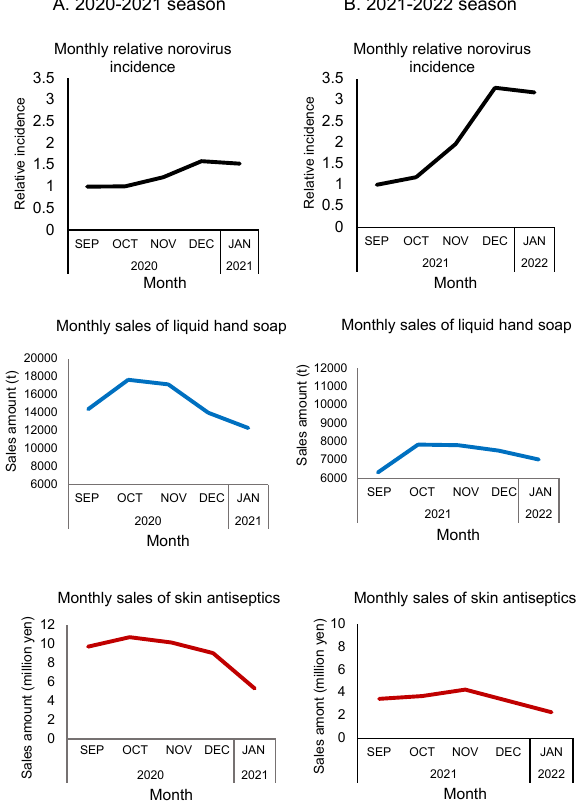
Fig. 3 Monthly relative incidence of norovirus and sales of hand hygiene products. Relative monthly incidence against the reference incidence in September and total sales in yen of liquid hand soap and skin antiseptics in A) 2020 – 2021 season and B) 2021 – 2022 season. The data were reviewed from the open-source of the government [in Japanese]. https: // www.meti.go.jp / statistics / tyo / seidou / result / ichiran